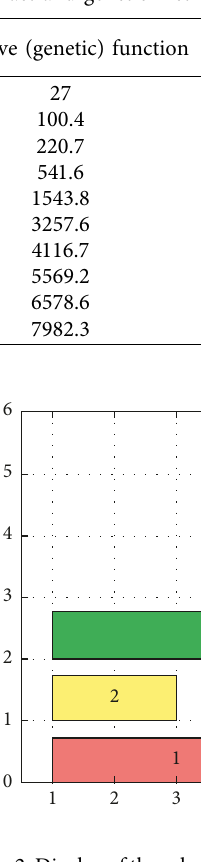
Figure 2: Display of the scheduling of activities with six activities in the genetic method.